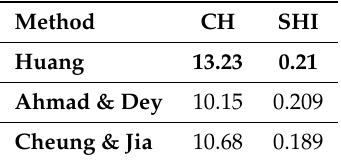
Table 2. Internal indexes. CH—Calinski–Harabasz index; SHI—Silhouette